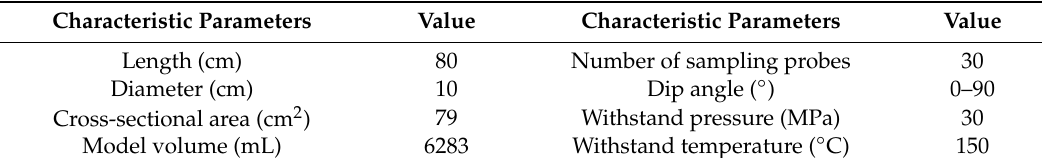
Table 1. Basic characteristic parameters of the experimental model.